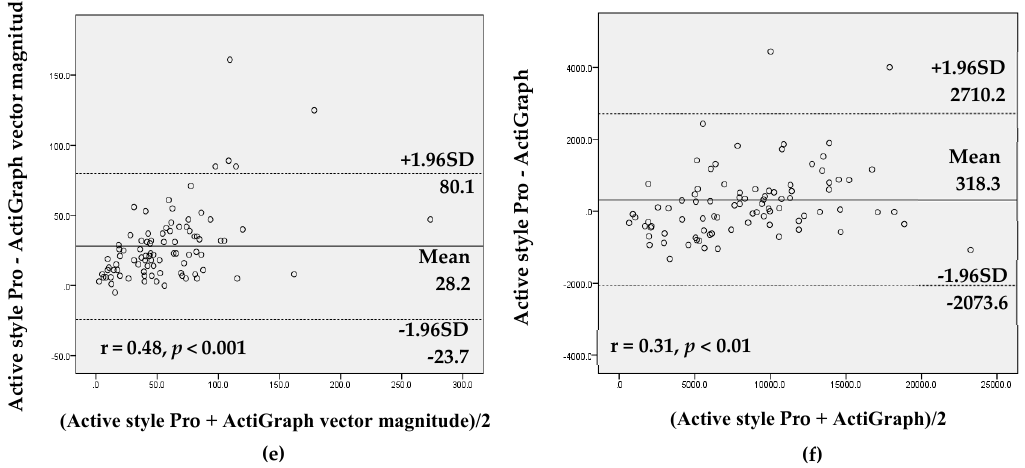
Figure 1. Bland–Altman analysis for the data agreement assessed with the Active style Pro and the ActiGraph vertical axis and vector magnitude (total sample including work and nonwork days): ( a ) sedentary behavior (SB) time, vertical axis; ( b ) SB time, vector magnitude; ( c ) light-intensity physical activity (LPA) time, vertical axis; ( d ) moderate-to-vigorous physical activity (MVPA) time, vertical axis; ( e ) MVPA time, vector magnitude; and ( f ) steps. Table 2. The mean di ff erences of PA output between Active style Pro and